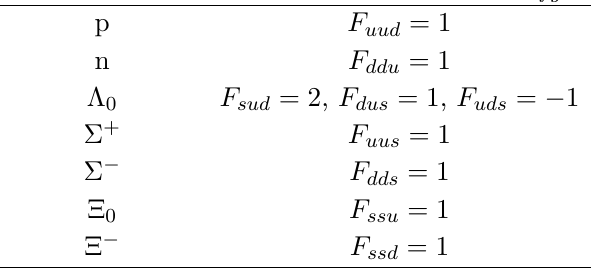
Table 10 . Flavour tensor F fgh defining the interpolating operators for spin- 1 / 2 baryons via eq. (4.28). The flavour indices can take values u , d , s , c .